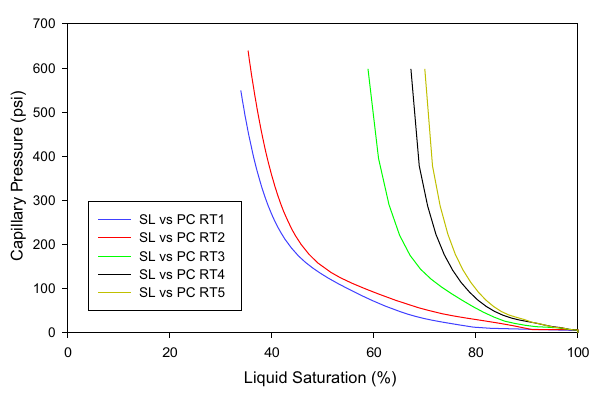
Fig. 8 Capillary pressure curves for gas–oil drainage process Fig. 9 Relative permeability curves in water–oil